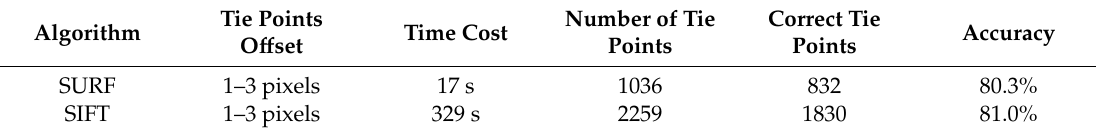
Figure 9. Partial view of the tie points obtained by SURF (showing only 50 tie points). Table 3. Precision parameter of tie points extraction